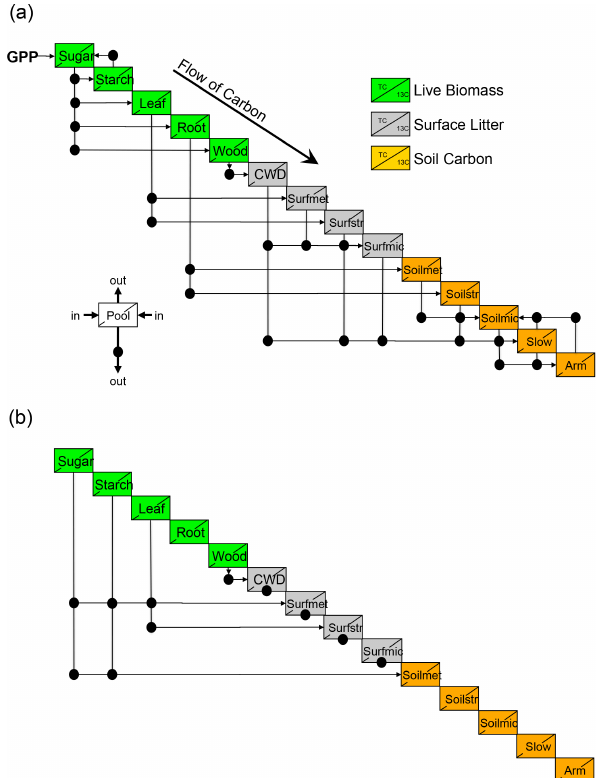
Figure 1. The modified SiBCASA pool configuration (a) , where each box represents a total carbon (TC) and 13 C pool. Carbon gen- erally flows from upper left to lower right: vertical lines are losses from each pool; horizontal arrows are gains to each pool; and dots represent the transfer of carbon from one pool to another, where a fraction is lost to the atmosphere as respiration. GPP minus the canopy respiration puts sugars into the sugar pool, which becomes available for growth and maintenance of leafs, roots, and wood. Part of the sugar and starch is transferred from one another to keep the ratio between sugar and starch around 1:9. Dying of biomass is mimicked by transferring carbon to the structural, metabolic, and microbial surface and soil pools. The autotrophic respiration results from growth and maintenance in the live biomass pools and het- erotrophic respiration results from microbial decay in the surface litter and soil carbon pools. The other pool configuration displays the flow of carbon introduced by fire disturbances (b) . Vertical lines represent pool losses, horizontal lines represent pool gains, and dots represent the TC and 13 C fire losses to the